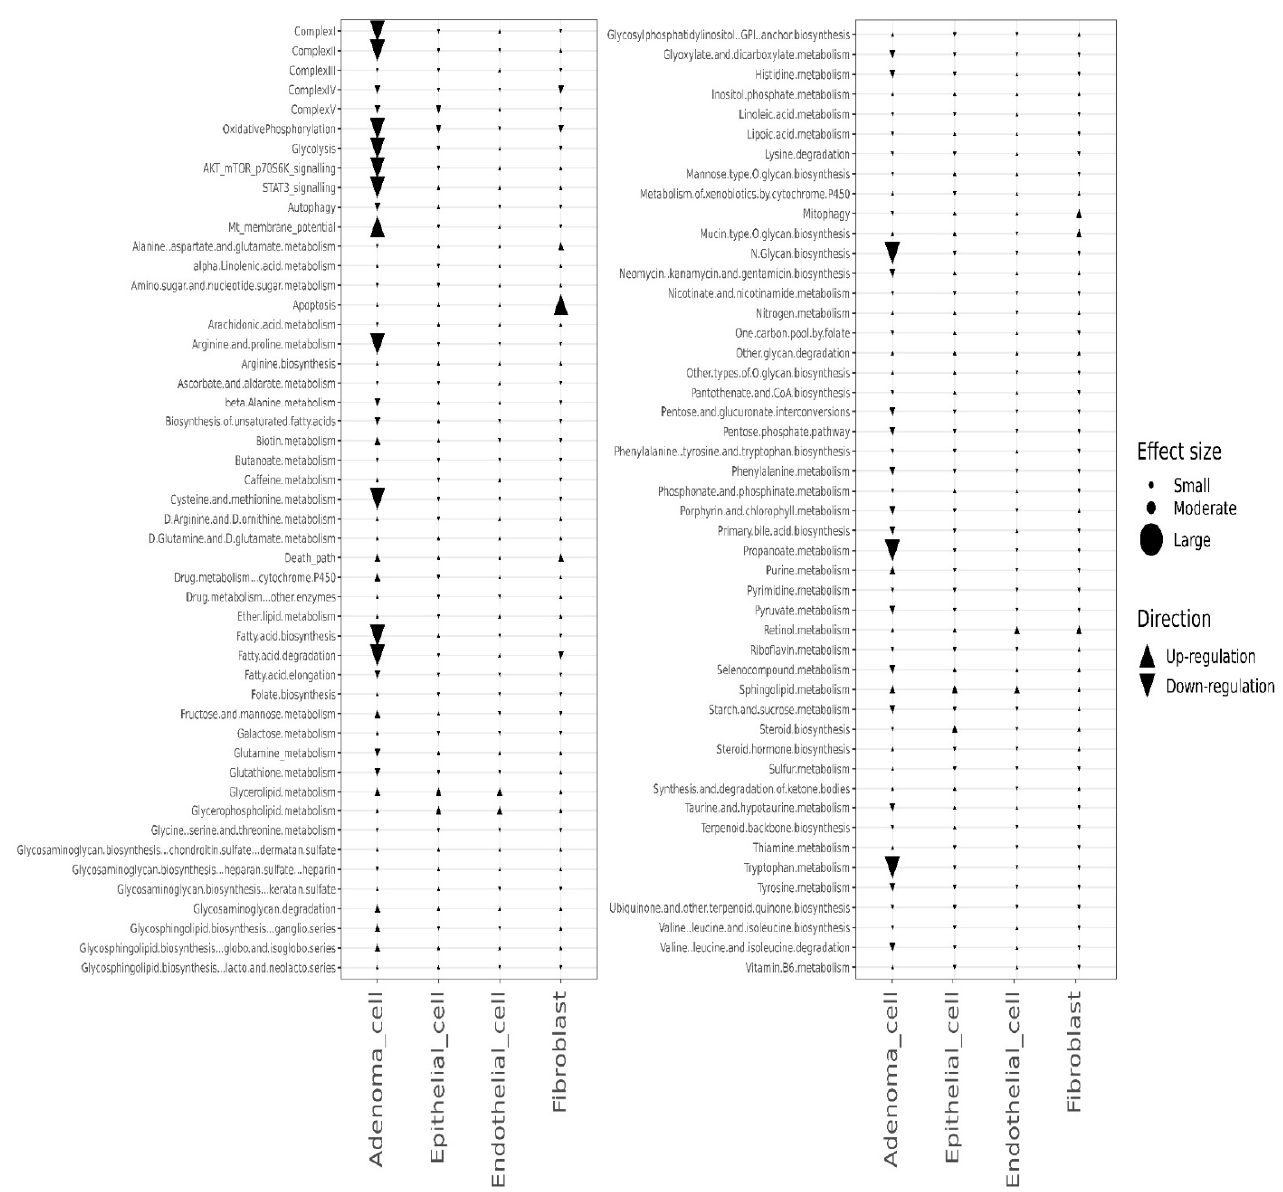
Figure 9. Pathway alterations in CD45 − cells from control vs combination treated mice. KEGG metabolism pathways and other pathways in CD45 − mouse lung cells were compared between the control and combined treatment groups.